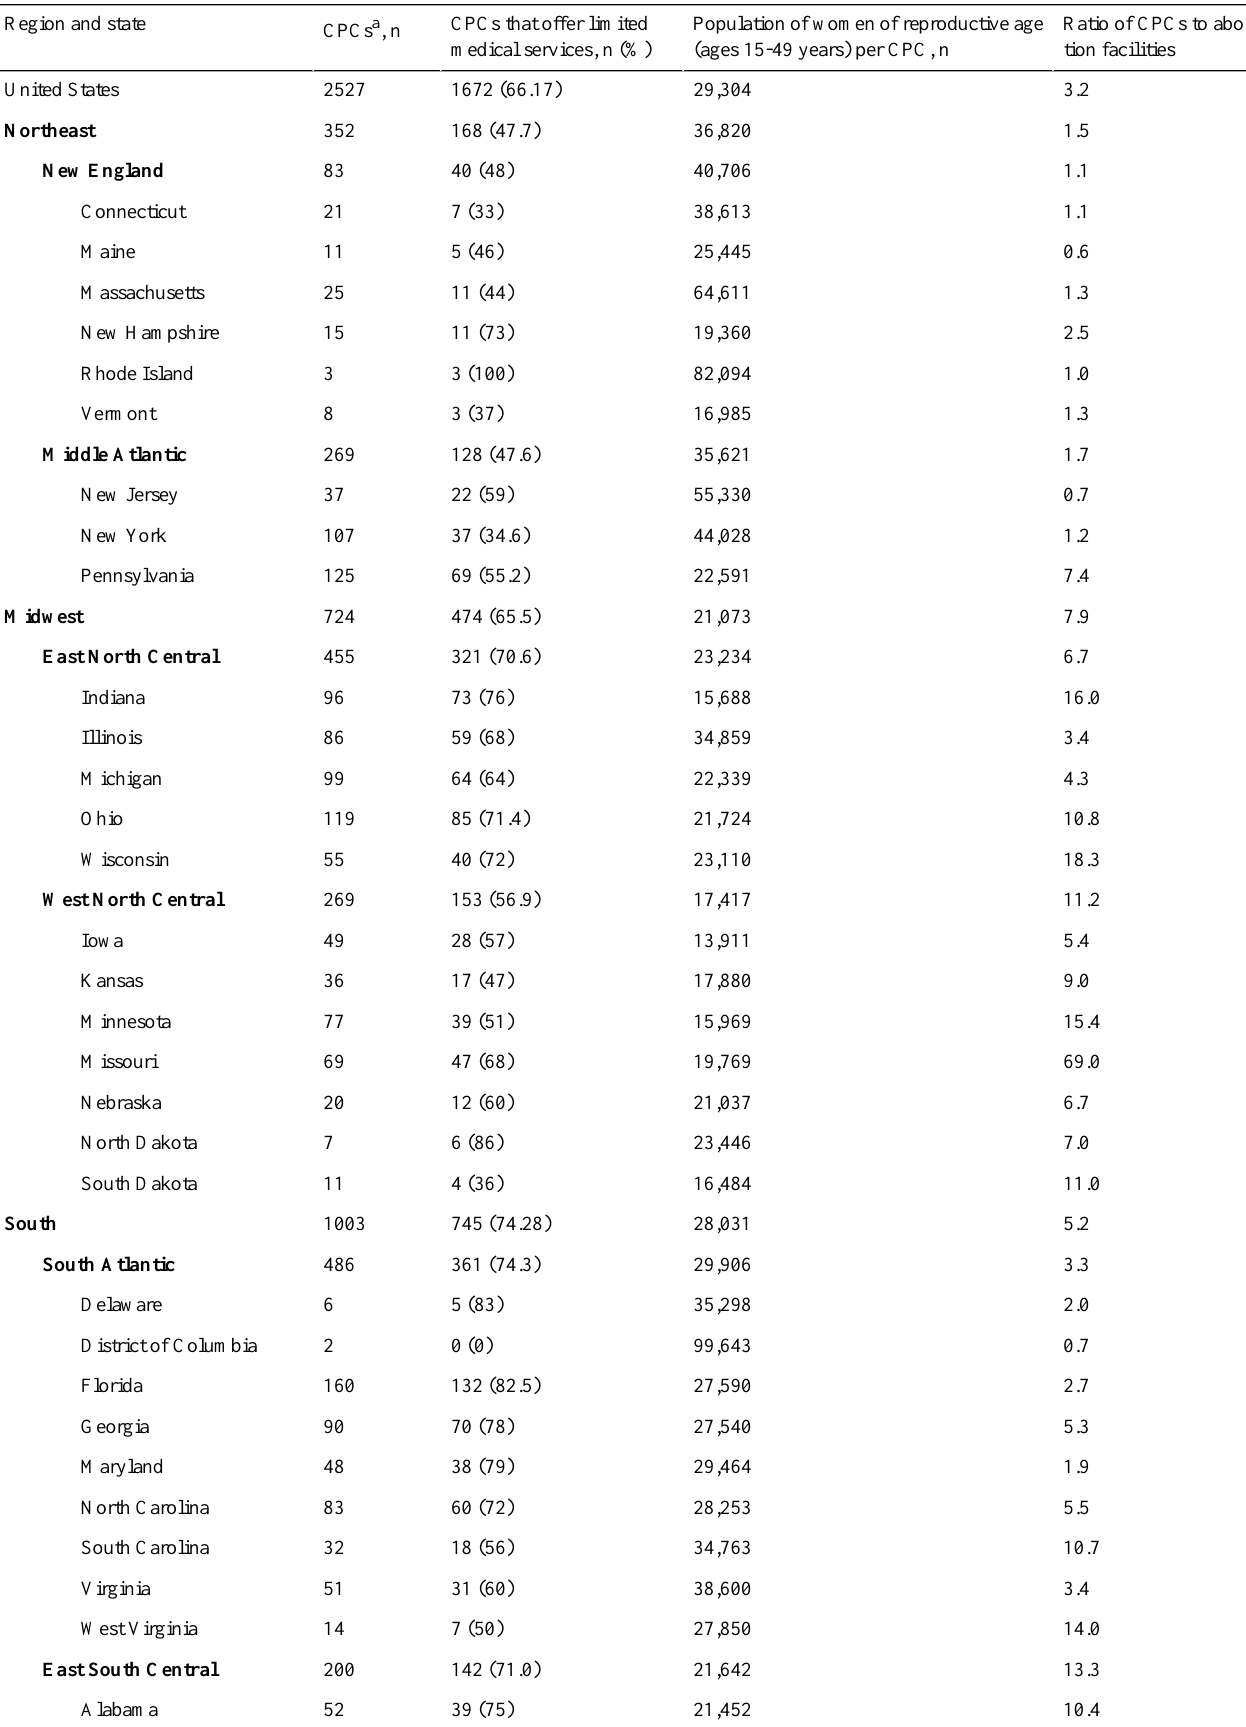
Table 1. Number of crisis pregnancy centers in the United States, by region and state, in 2018.